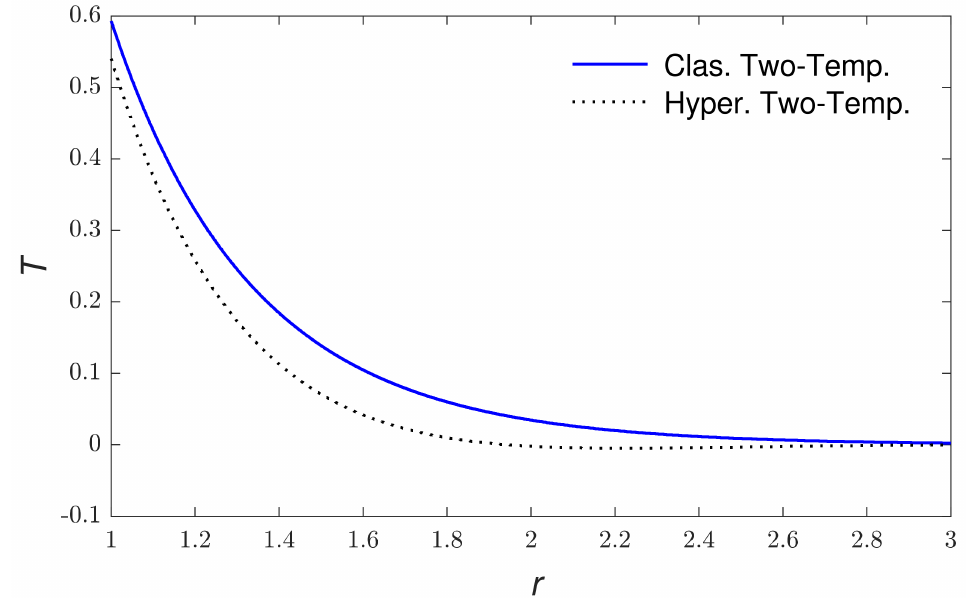
Figure 3. The thermodynamic temperature variations along the redial